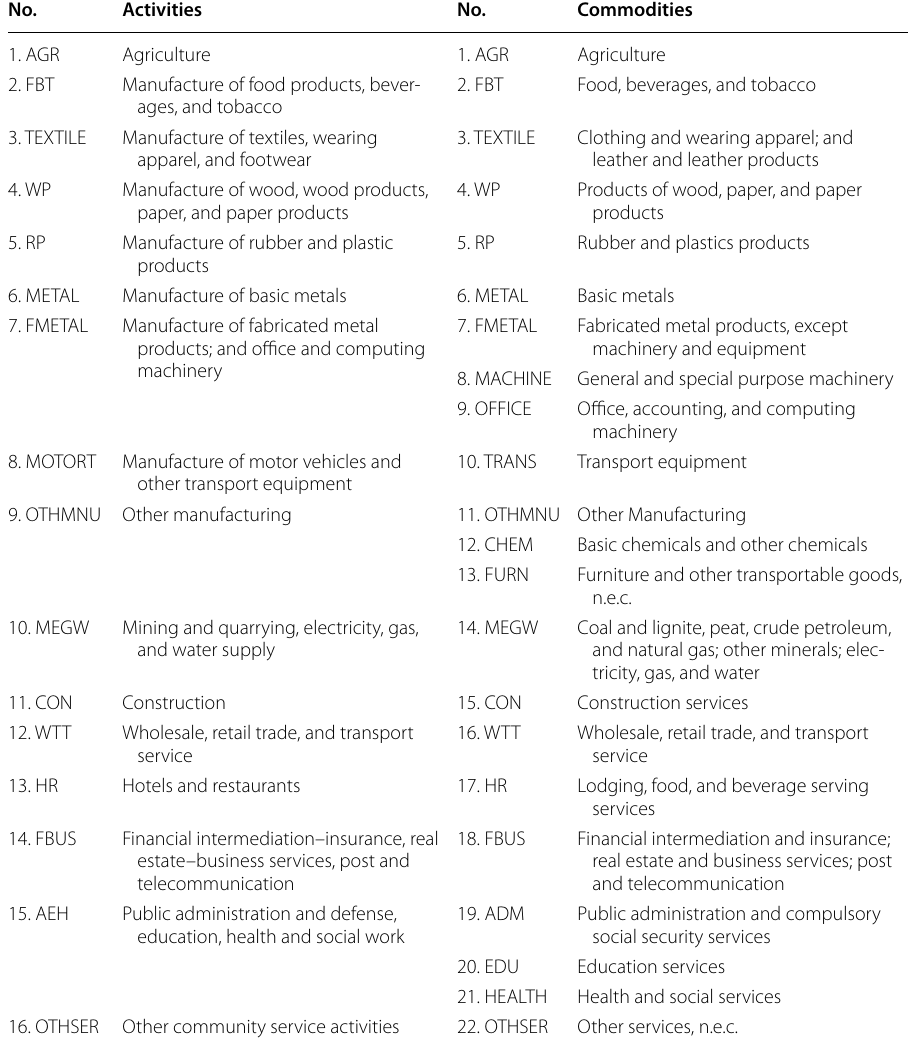
Table 4 Industries and commodities in the Cambodia’s SAM, 2011. Source : Heng et al. (2014), aggregated by